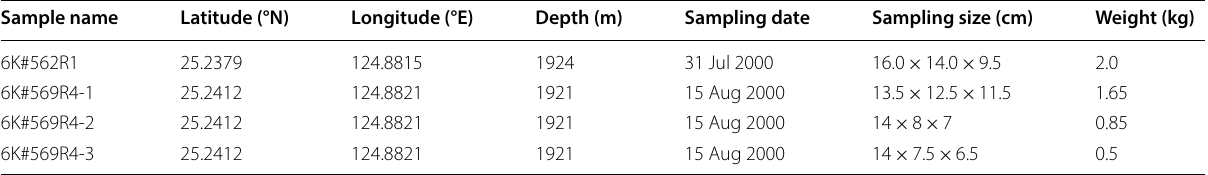
Table 1 Location and sampling details of the studied volcanic rock samples from the Irabu knolls of the Okinawa Trough;